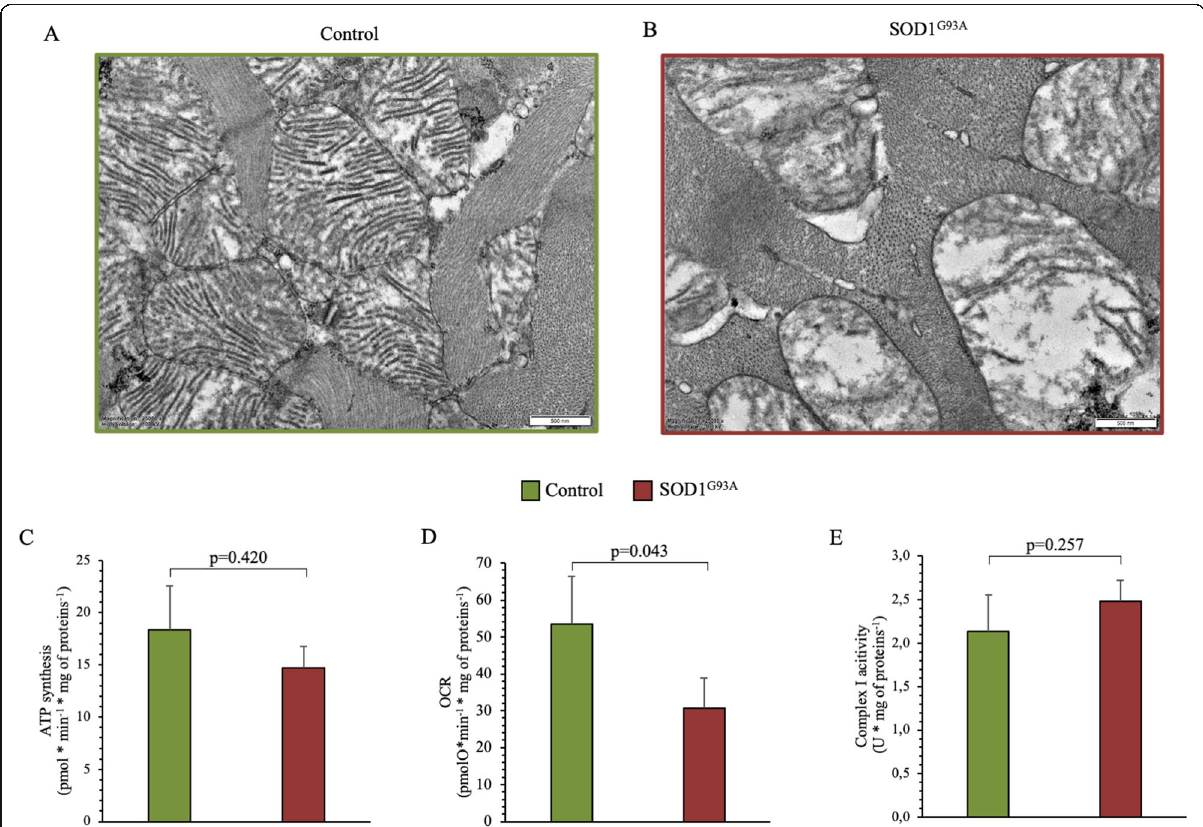
Fig. 7 Mitochondrial ultrastructure and bioenergetics activity in cardiac myocardium of SOD1 G93A and control mice. a , b Electron microscopy representative images of control SOD1 G93A myocardium. c , d ATP synthesis and oxygen consumption rate stimulated by pyruvate/malate in control (green column) and SOD1 G93A (red column) of isolated mitochondria. e Complex I activity in isolated mitochondria of control (green column) and of mutated muscles (red column) studied by the FeCN reduction in the presence of NADH. Data are expressed as mean ± SD, n = 3 for each group. Student t test for unpaired data was used for statistical